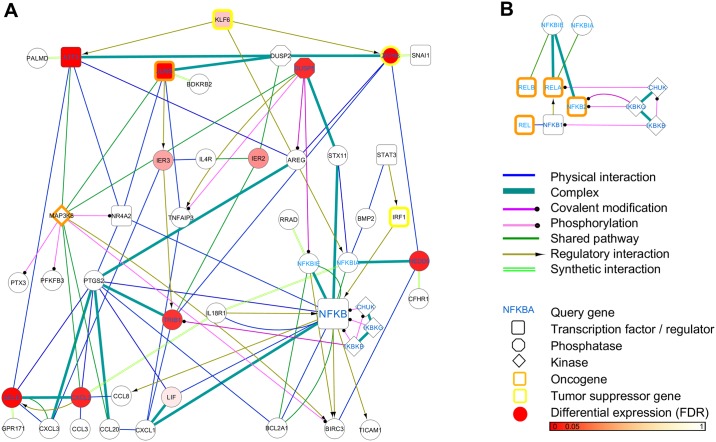
A novel predicted NFκB pathway specific to prostate cancer.(A) A pathway of putative molecular activities surrounding NFκB as predicted by our computational framework (Fig 1): the pathway results from a genome-wide functional interaction specific to the NFκB pathway in human prostate cancer and contains 50 genes connected by 112 mechanism-specific interactions. To generate this novel NFκB pathway, we extracted a high-confidence subnetwork from the genome-wide functional interaction network (see Methods) around 18 query genes in total (blue type), including five NFκB complex genes (NFκB1, NFκB2, REL, RELA, RELB), five NFκB specific inhibitors (NFκBIA, NFκBIE, IκBKB, IκBKG, CHUK), and eight genes found to be differentially expressed between lethal and indolent prostate cancer (Table 1). (B) We recovered all known molecular interaction mechanisms between NFκB complex members and their inhibitors (S17 Table).